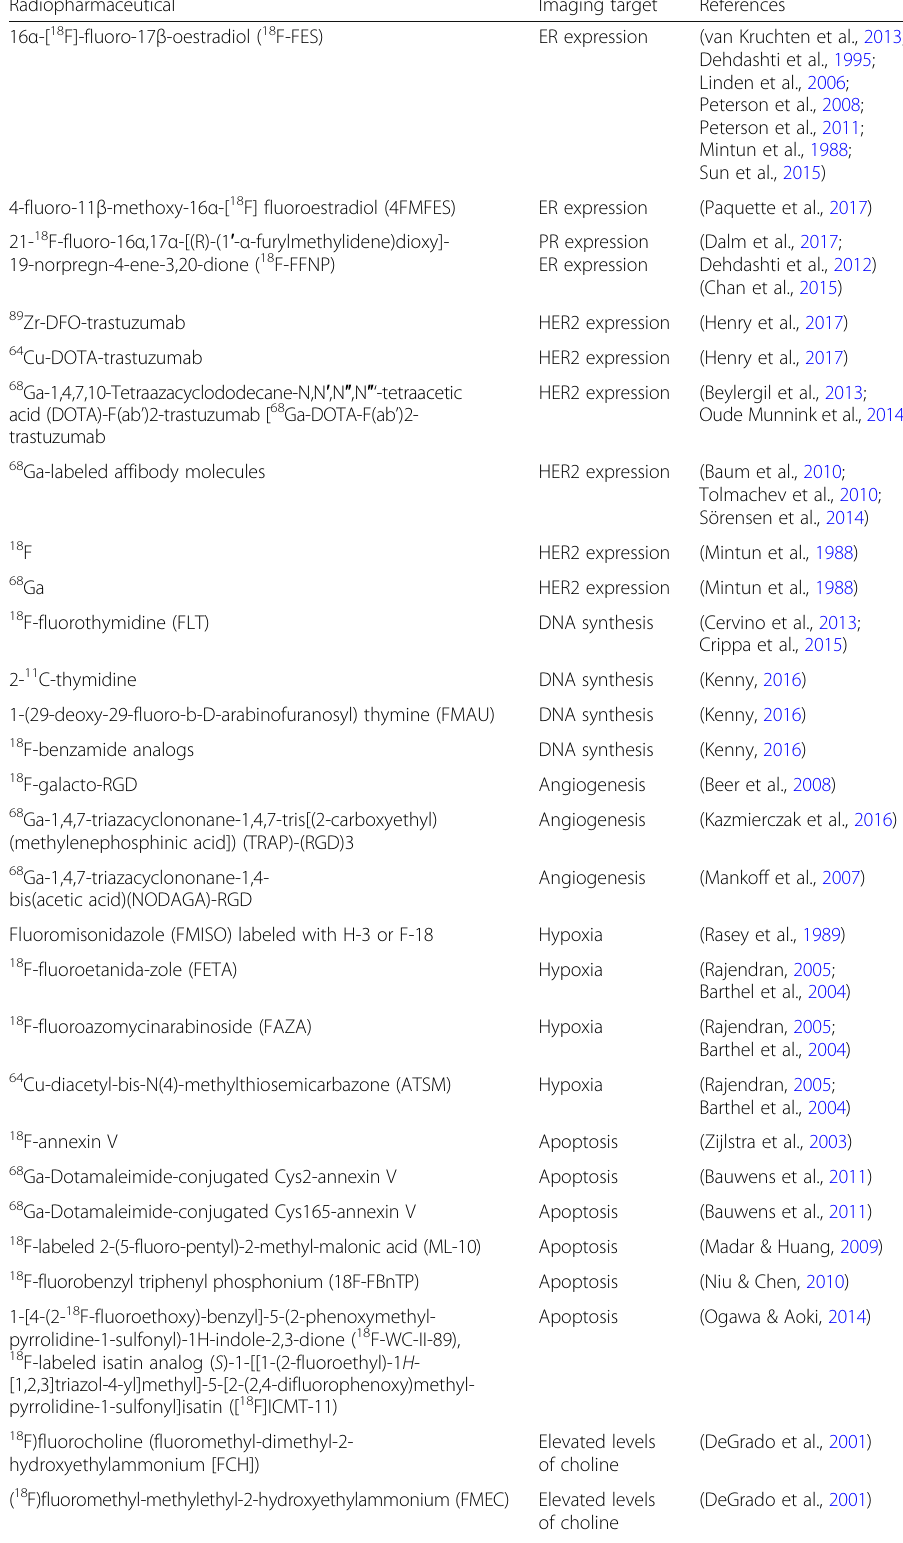
Table 1 Targeted pet/ct imaging and